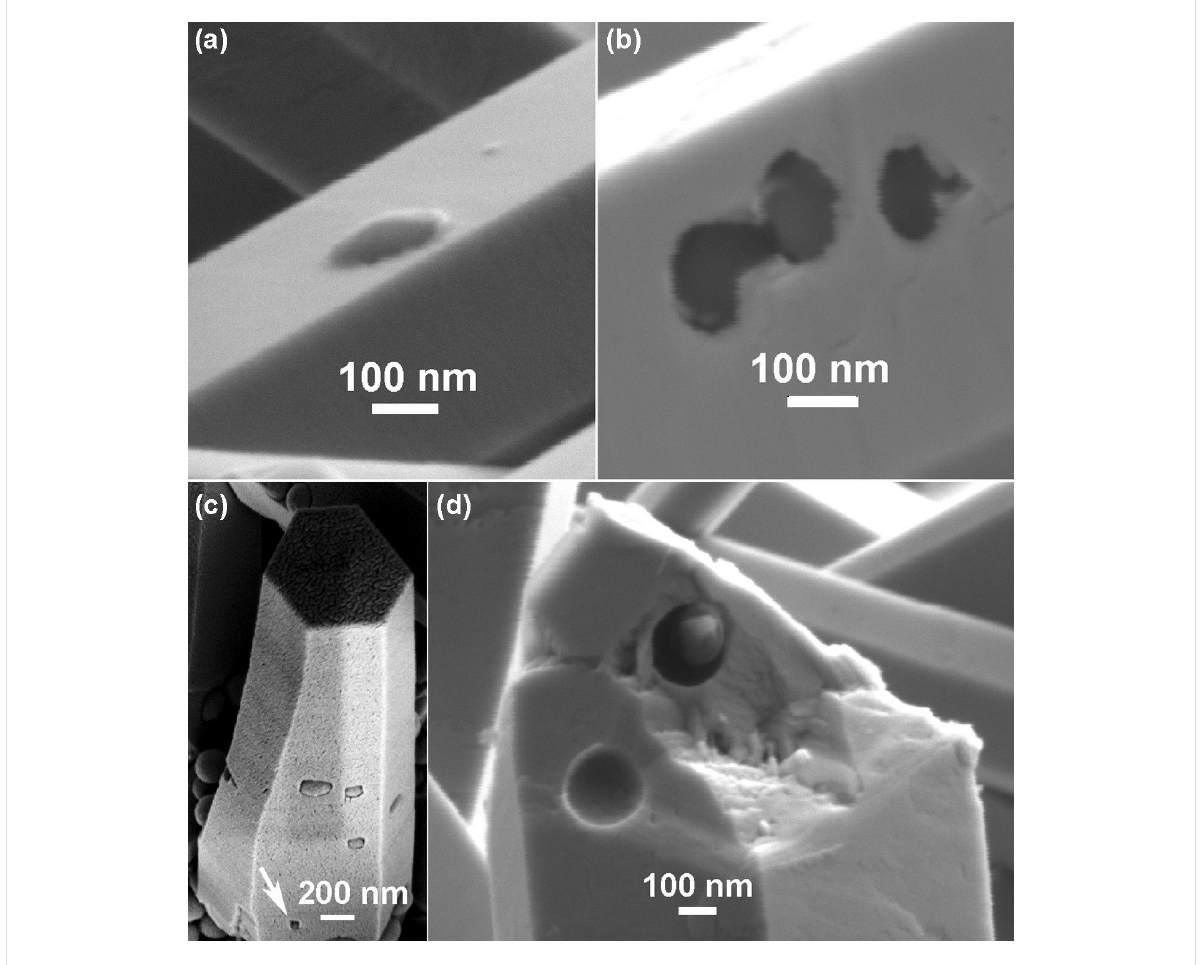
Figure 4: FE-SEM Images showing the encapsulation of nanobeads into ZnO nano/microrods after different regrowth processes. (a) Most part of the nanobead is embedded into a nanorod. (b) Nanobeads are deeper embedded into a nanorods, leaving holes in the surface. (c) A thick microrod showing that the embedded nanobeads are slightly exposed. (d) A fractured microrod showing a completely encapsulated nanobead